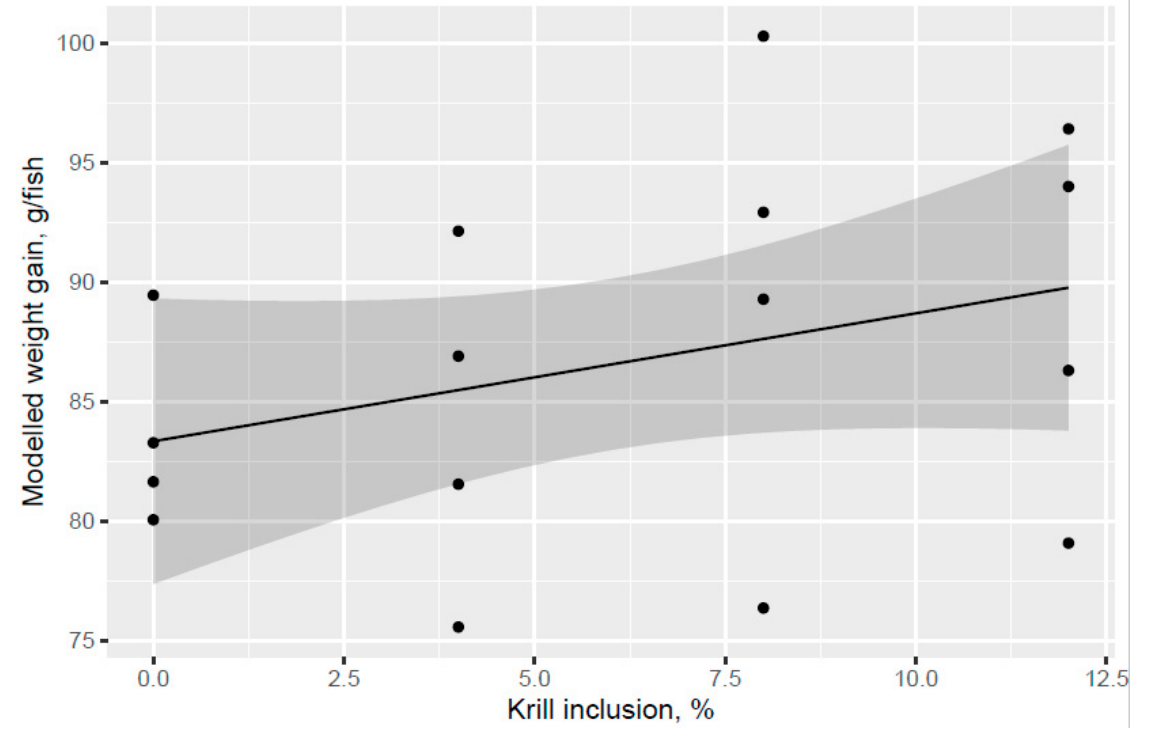
Figure 3. Modelled weight gain with increasing KM inclusion after 53 d of feeding in the freshwater pre-transfer phase plotted with 95% credible intervals as the grey band. Dots denote observed tank mean weight gain.